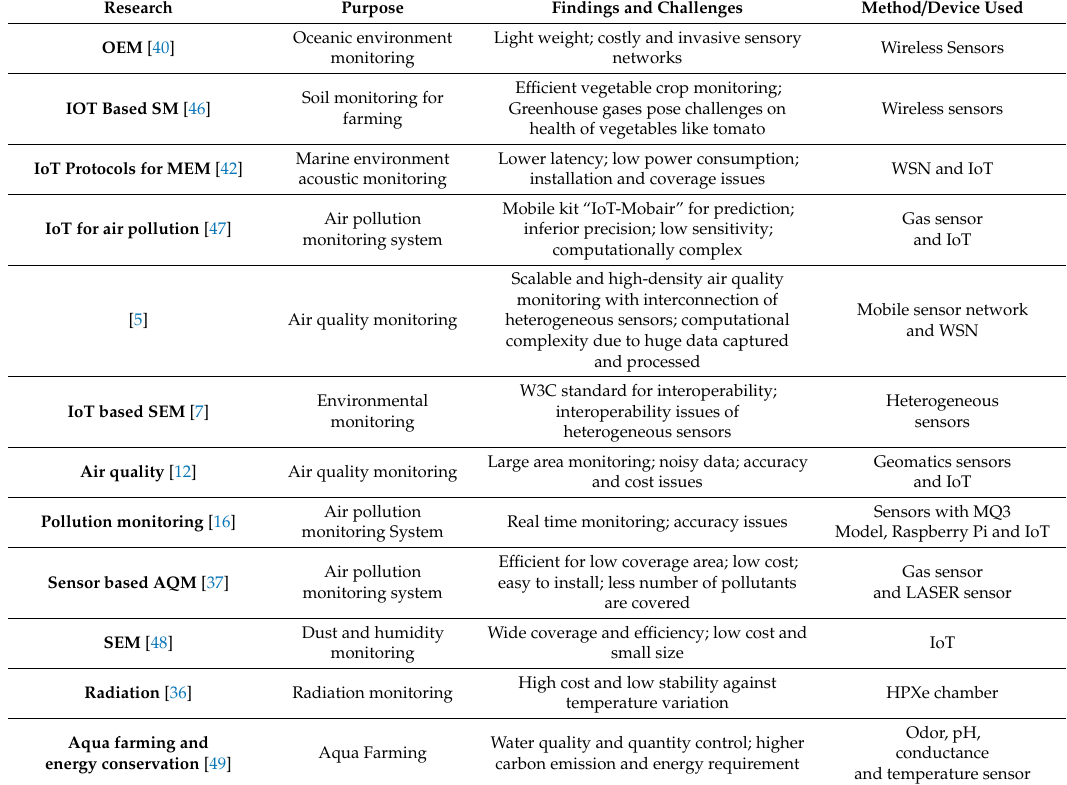
Table 1. Research studies based on purpose and applications of environment